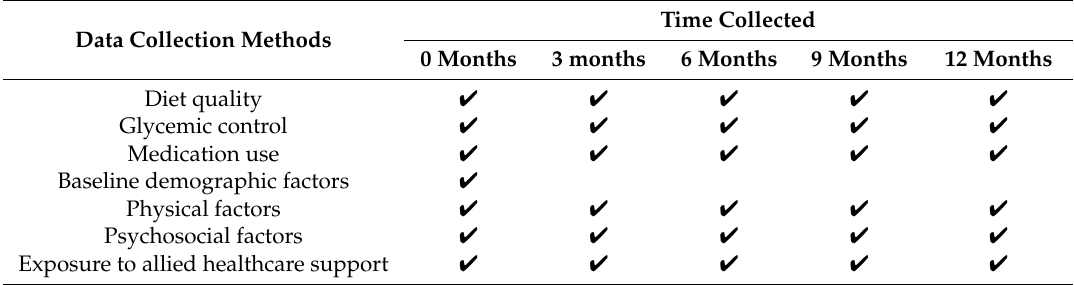
Table 2. Overview of data collection points in the 3D Longitudinal